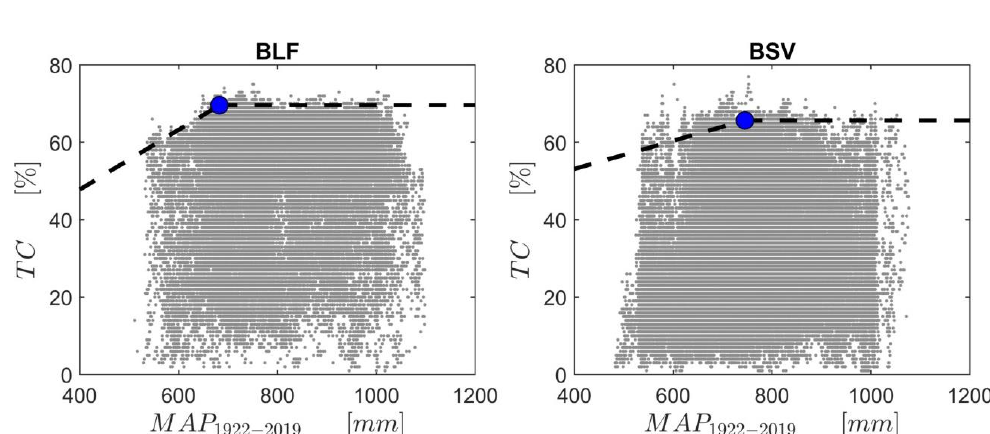
Figure 5. Scatterplot of MODIS MOD44B tree-canopy coverage (TC) as a function of MAP 1922 ‒ 2019 (mm) for broad-leaved forests ( left ) and for bushy sclerophyllous vegetation ( right ) for the year 2008. Maximum tree cover is represented by using a 99th quantile piecewise linear regression (black dotted line). The blue dot in each panel is the change point (identified by the regression analysis, MAP cp ) at which the maximum tree cover ( TC max ) is attained.